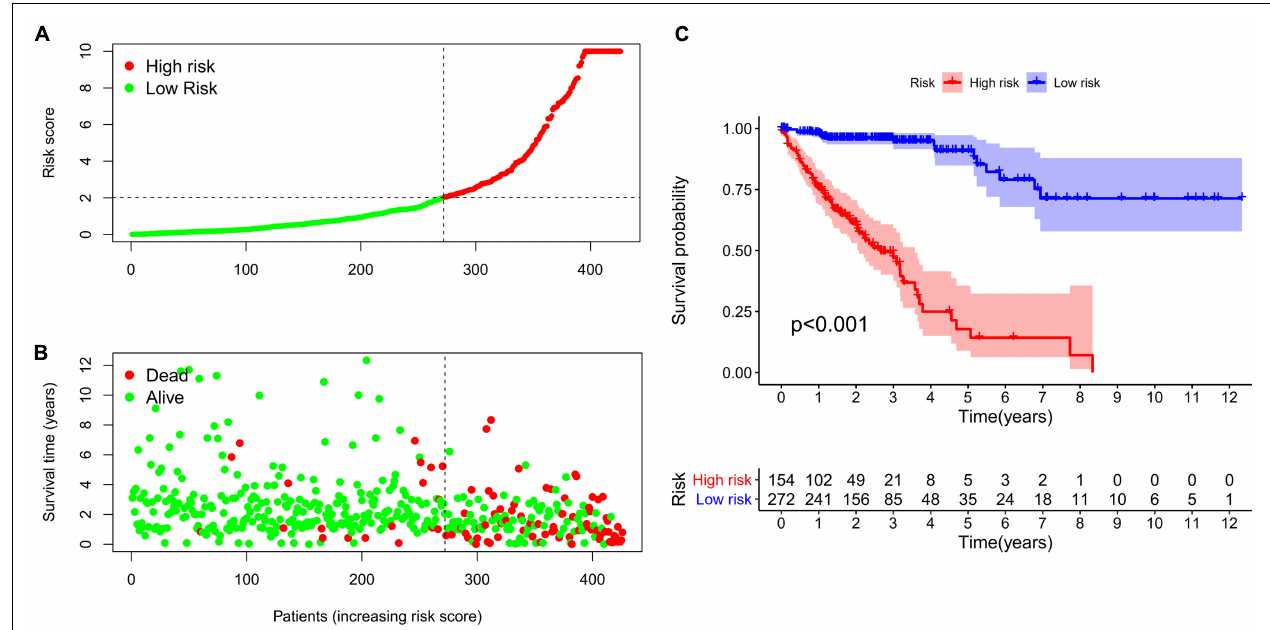
FIGURE 5 | (A,B) Risk scores (A) and survival outcome (B) of each case are shown. (C) Patients in the low-risk group experienced a longer survival time tested by the Kaplan-Meier (KM)